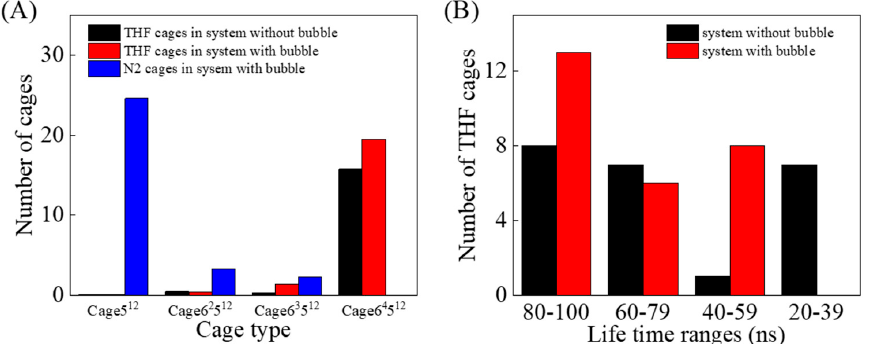
Figure 9. ( A ) The number of THF-filled cages and N 2 cages, and ( B ) lifetime distribution of THF- filled cages in the last 100 ns. cages in the last 100